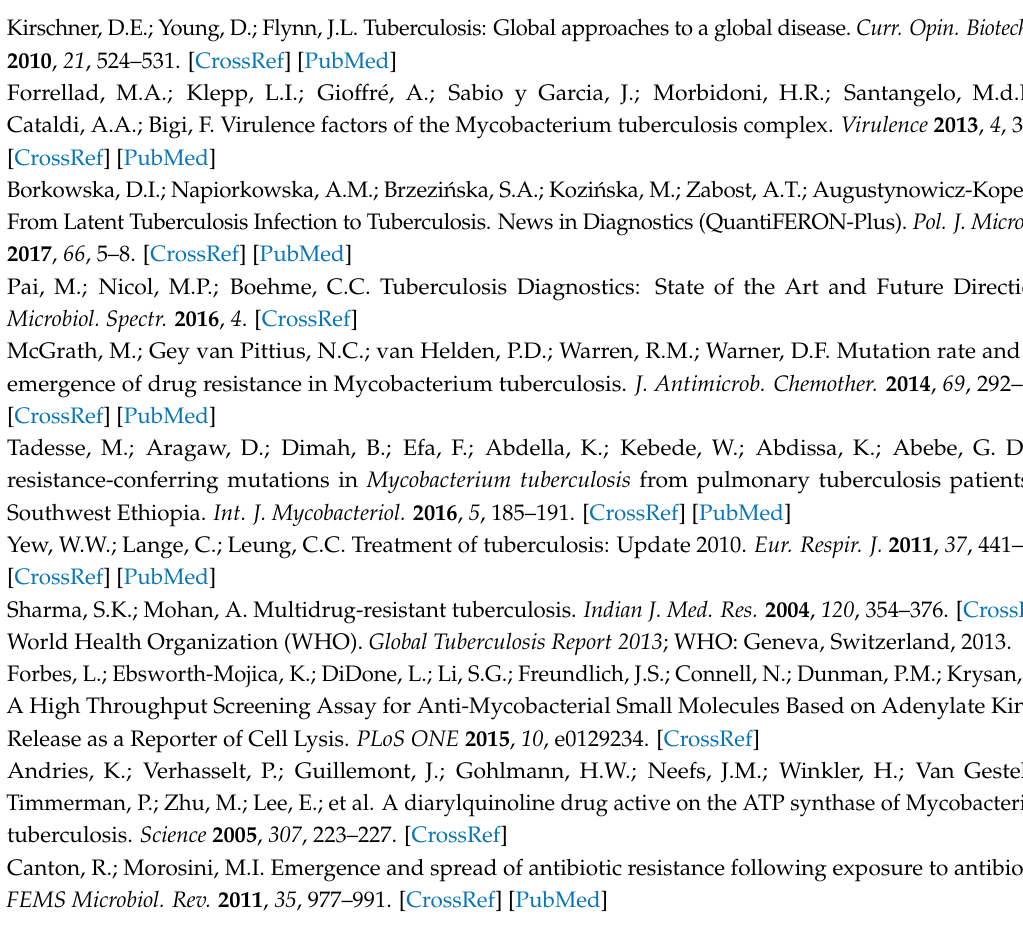
Figure S1: Acid-fast staining of the drug-susceptible and MDR Mycobacterium smegmatis strains following exposure to cholesterol. Scale bar is 5 µ m; Table S1: Optical Density of M. smegmatis as a measure of cell survival and proliferation during isolation of the MDR strains; Table S2: Amount of antibiotic in the paper discs used for the disc diffusion assay; Table S3: Amount of antibiotic in the paper discs used as neighbours for the selected